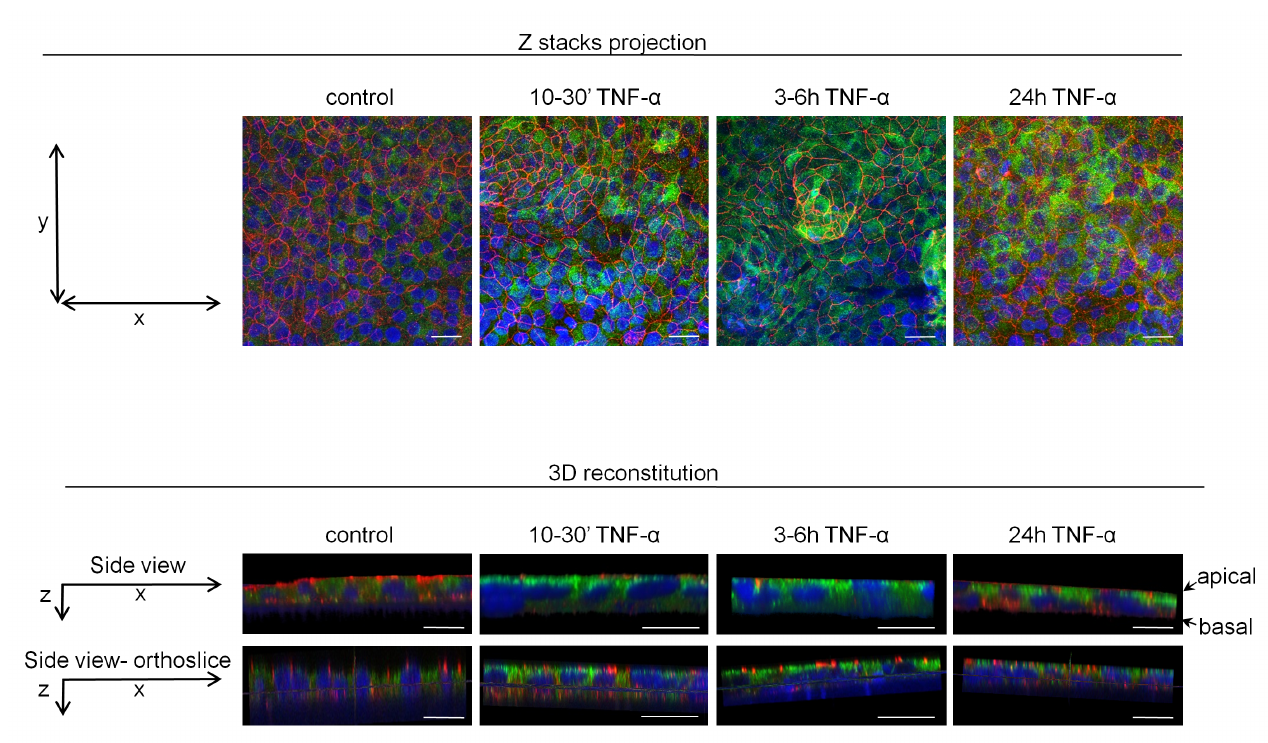
Figure 5. Increased apical localization of F508del-CFTR in primary HBE cell cultures upon treatment with TNF α . Differentiated primary HBE cell cultures grown at an air-liquid interface were incubated with 50ng/ml TNF α for 10–30min, 3–6h and 24h. CFTR immunodetection was performed with 24.1 anti-CFTR antibody and analyzed with confocal microscopy. Green staining represents CFTR (Alexa Fluor 488), red color staining represents ZO-1 protein of tight junctions (Alexa Fluor 594) and blue DAPI staining visualizes nuclei. Independent TNF α treatments and CFTR immunodetection were performed on HBE cells from three different F508del/F508del CF patients. Representative images of one experiment are demonstrated (Scale bars =